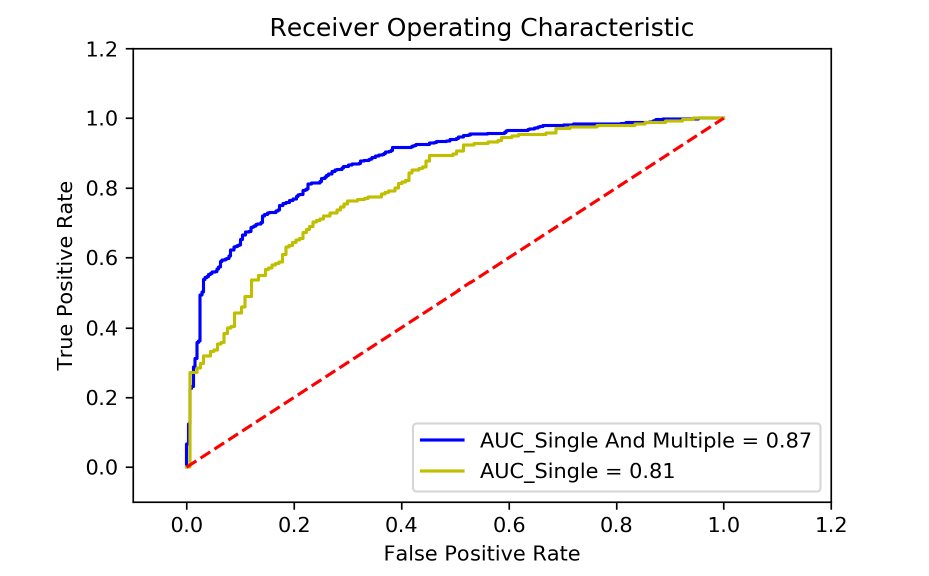
Figure 4. Comparison between different feature selection